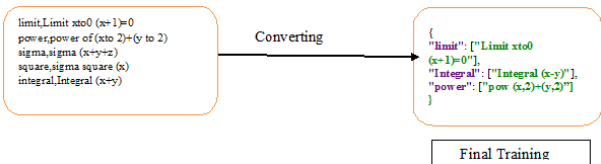
Figure 1 . Procedure of TensorFlow based retrieval of mathematical